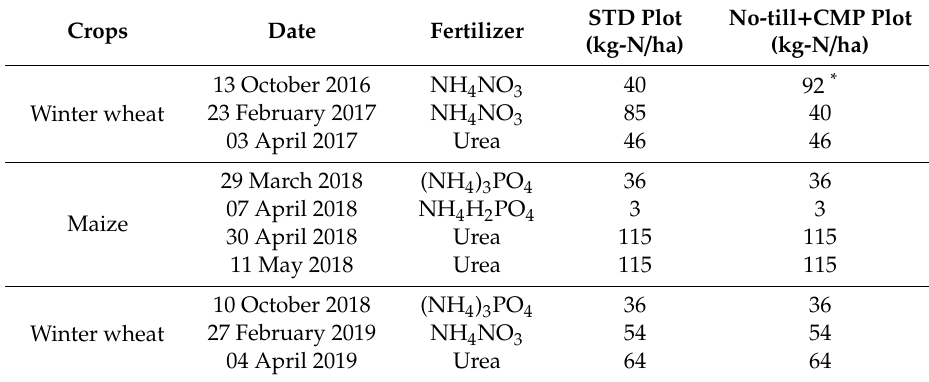
Figure 1. Satellite image sourced from Google Earth on 22 June 2017, with the location of STD (classic fertilization and tillage practices) and No-till+CMP (no-tillage practice) plots and of permanent instrumentation. Table 1. N fertilization events and rate in the STD and No-till+CMP experimental plots. Crops Date Fertilizer